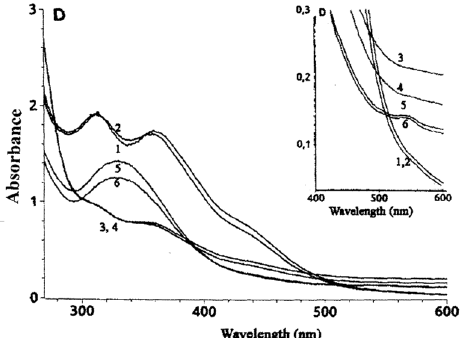
Figure 12. Optical absorption spectra of B-DNIC-NAC solutions (5 mM), with molar ratios of “free NAC” and B-DNIC-NAC of 4:1 (curve 1) or 1:1 (curve 2). The solutions were diluted ten times. Curves (3, 4) and (5, 6), respectively—the absorption spectra of solutions of the same complexes, heated after being diluted two times at 80 °C in anaerobic conditions for 7–9 and 2–3 min, respec- tively. Spectra 5 and 6 with absorption bands at 334 and 543 nm are related to S-NO-NAC. The inset shows the absorption spectra of all those solutions with higher spectrometer sensitivity in S-NO- NAC band absorption region at 543 nm [87]. (With permission).